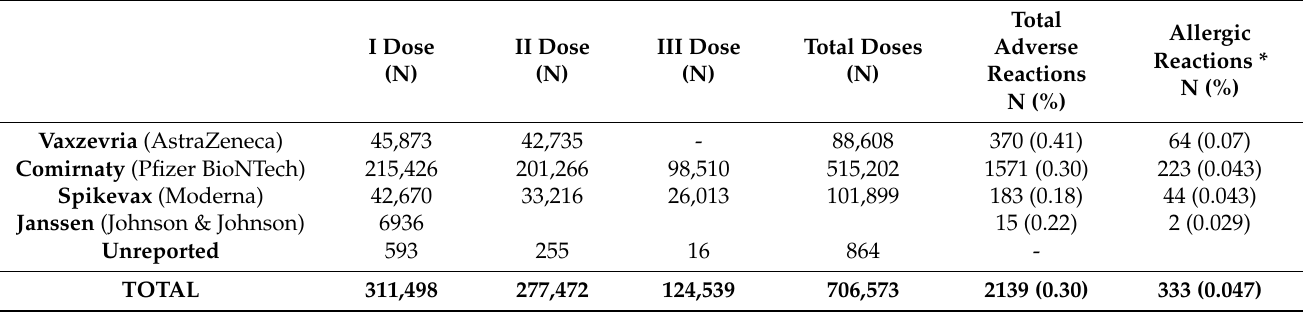
* urticaria, angioedema, itching, asthma and rhinitis. Thirty- three cases were classified as “severe reactions” requiring treatment and medical support. No anaphylaxis was recorded.